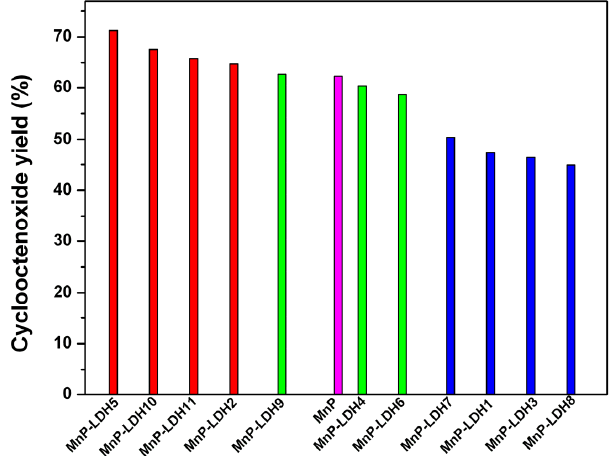
Figure 11. Comparison of the product yield obtained with MnP during homogeneous